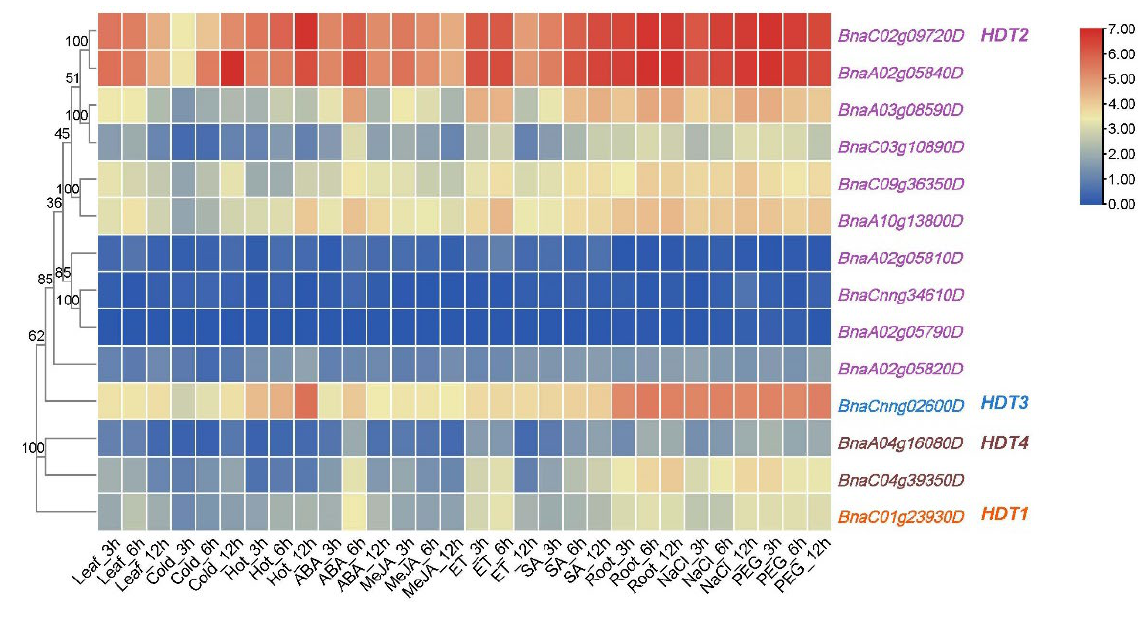
Figure 5. Expression of BnaHDT genes under different abiotic stresses and plant hormone treatments. The expression levels (TPM values) of BnaHDT genes are indicated by differently colored rectangles. Leaf: untreated leaves; Cold: leaves treated with − 4 ◦ C. Hot: leaves treated with 40 ◦ C; ABA: leaves